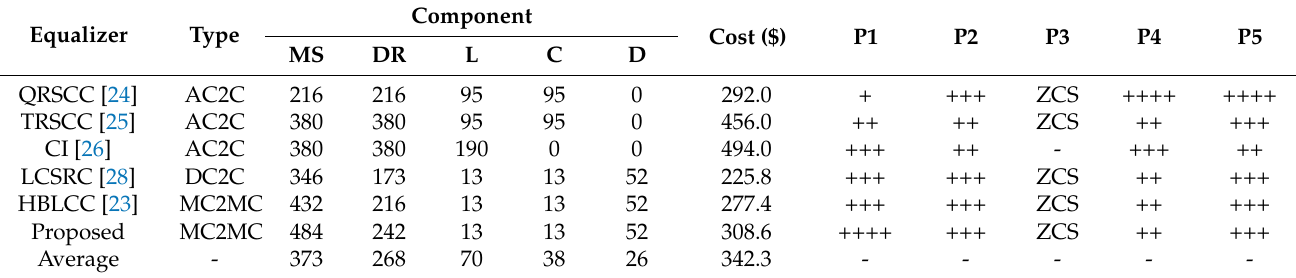
Table 5. Systematic comparison example for a 96 cells battery pack composed of 12